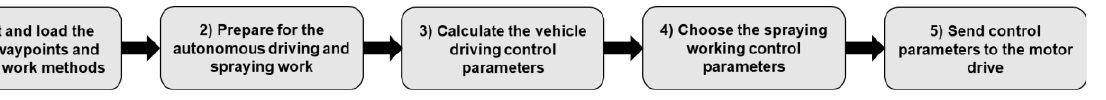
Figure 3. Process of the autonomous driving algorithm.